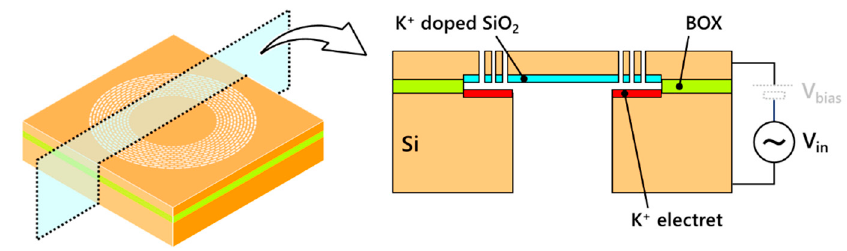
Figure 2. Concept of narrow-gap electret fabrication at inner surface of SOI. Electret augments out-of-plane motion of membrane fabricated on device layer.